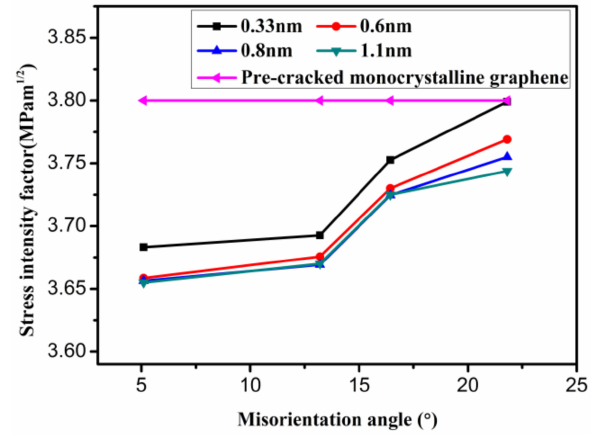
Figure 12. The variation in the mode I critical stress intensity factor as the misorientation angle